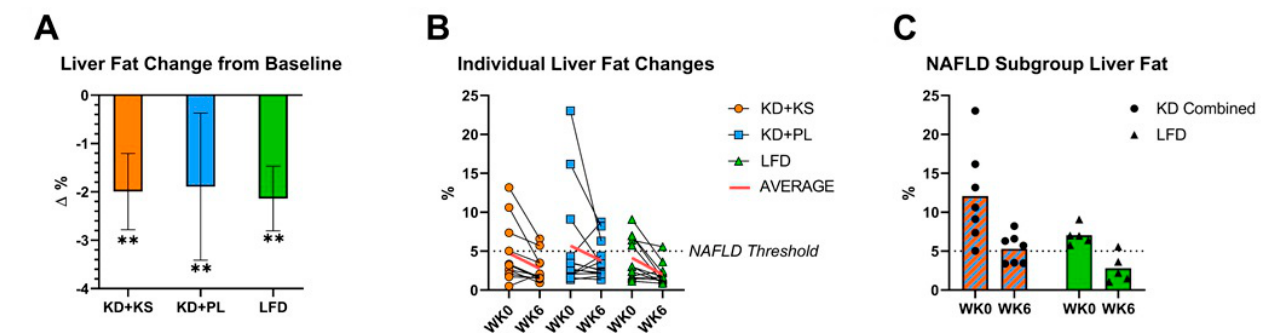
Figure 1. ( A ) Mean and ( B ) individual participant changes in total liver fat after 6-week ketogenic and low-fat diets. ( C ). total liver fat in a subset of participants with nonalcoholic fatty liver disease (NAFLD). ** = p < 0.01 from baseline. KD = ketogenic diet. KS = ketone supplement. LFD = low-fat diet WK0 = baseline. WK6 = post-intervention.